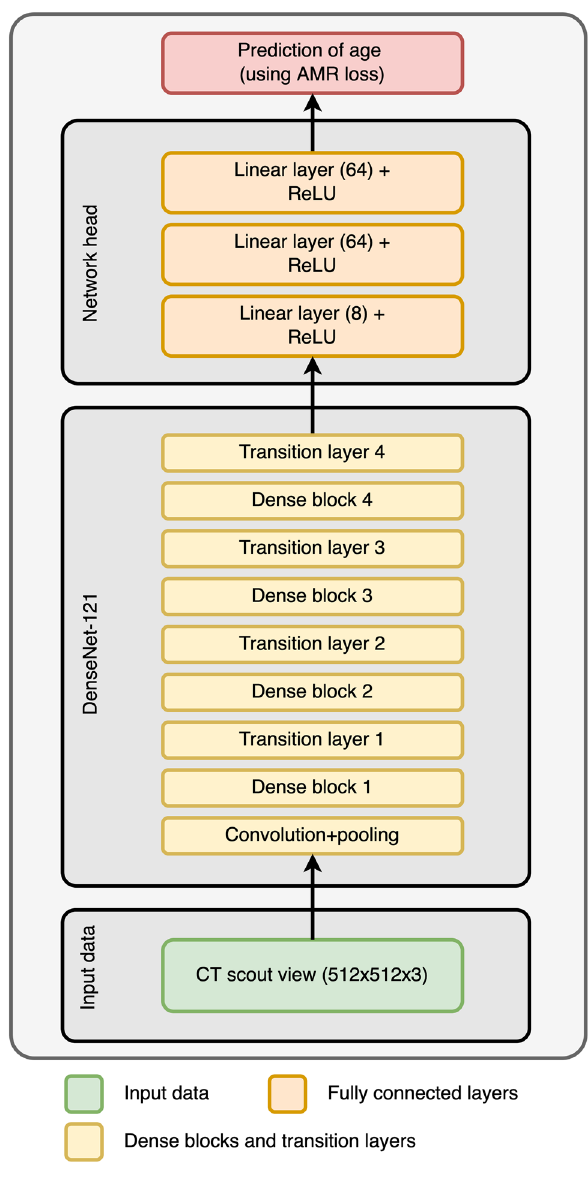
around 7.0 million tunable